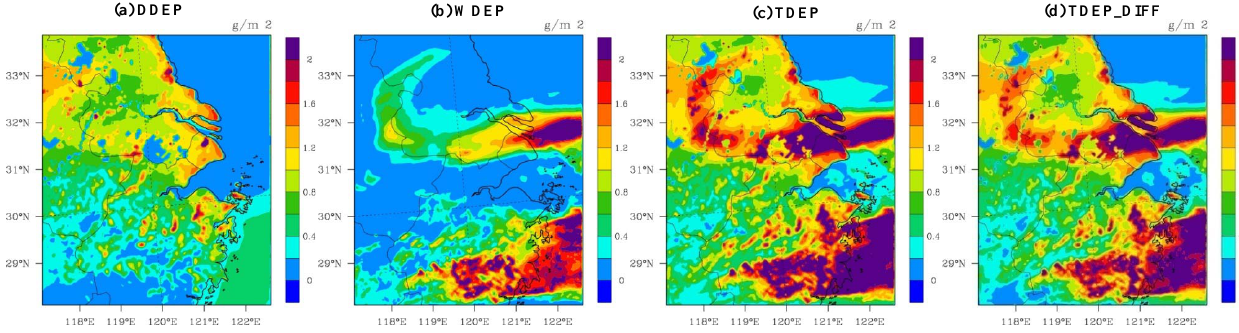
Fig. 9. The PM 10 deposition in the YRD region from 1 to 6 May. Fig.9. The PM 10 deposition in the YRD region from 1 to 6 May